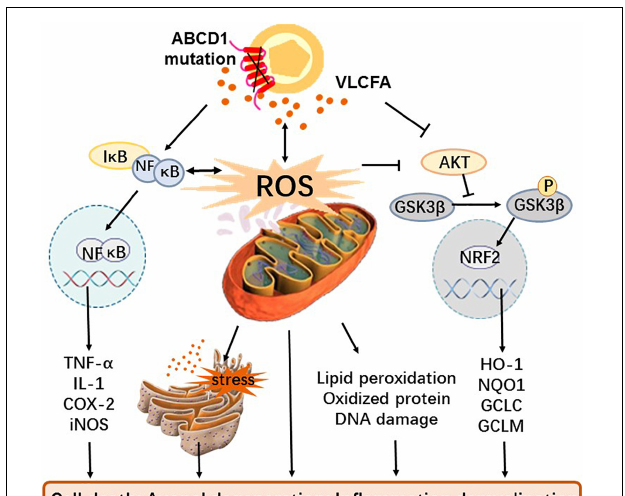
FIGURE 1 | The role and mechanism of oxidative stress and inflammation in X-ALD. Mutations in the transmembrane protein ABCD1 gene on the peroxisome prevents VLCFA from being transported to the peroxisome for β -oxidation, resulting in the accumulation of VLCFA in vivo . Dysfunctional peroxisome and cumulative VLCFA not only causes mitochondria that give rise to excessive ROS and oxidative stress but also directly interferes with the GSK3 β -NRF2 antioxidant pathway leading to redox imbalance and activate the NF- κ B pathway to induce inflammation. In addition, excessive ROS can also affect antioxidant systems as well as inflammatory pathways, cause endoplasmic reticulum stress with or without VLCFA, and generate macromolecular peroxidation damage. These alterations eventually cause cell death, axonal degeneration, and even inflammatory